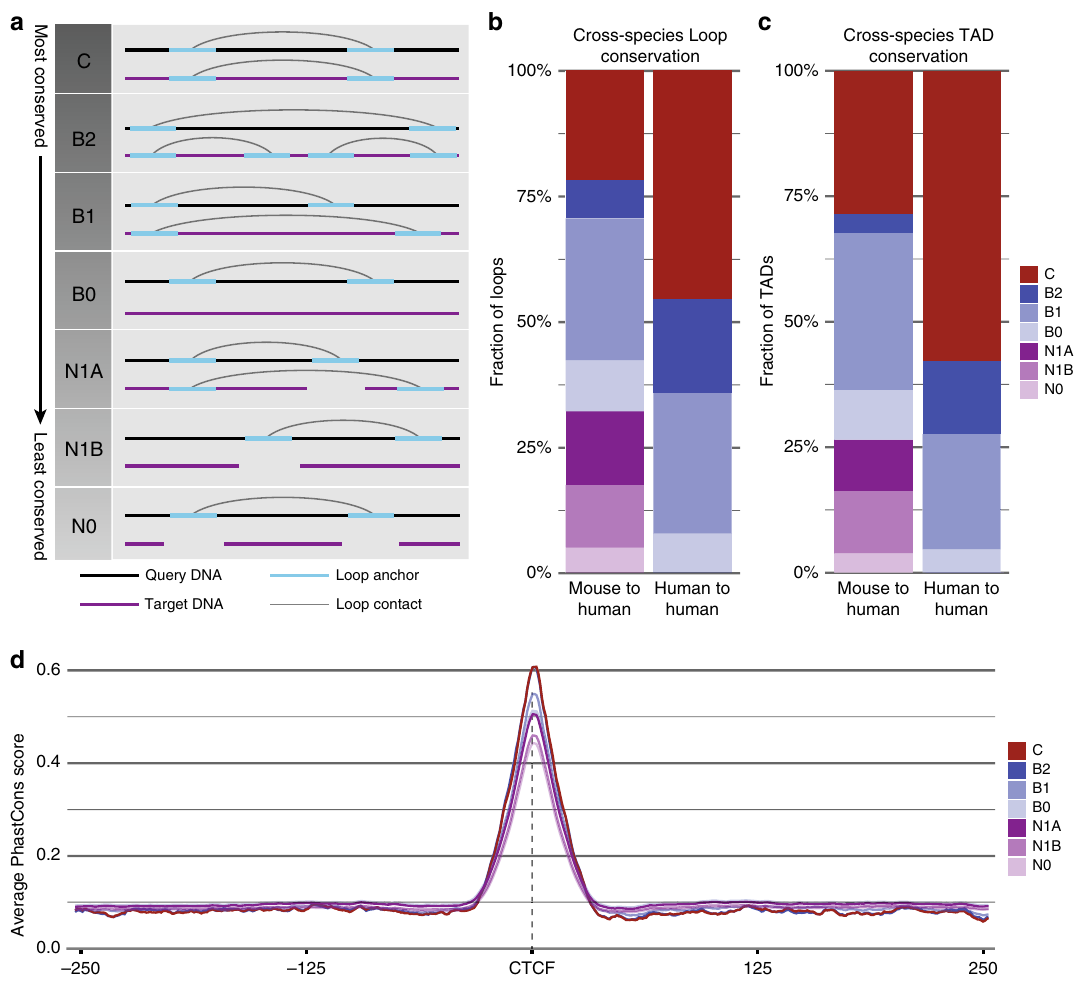
Fig. 5 Conservation classes describe loop co-occurrence patterns across cells and species, and are correlated with underlying phylogenetic conservation. a Conservation classes describe varying degrees of loop conservation between a query cell and a target cell based on sequence mappability and presence of a loop anchor at the syntenic locus. Diagrams illustrate the possible arrangements when comparing a query loop to a syntenic region in the target cell, with their corresponding conservation class labels. b , c Conservation class assignments from all pairwise comparisons between different cell types were aggregated into human – human and mouse – human comparisons. b Contributions of each conservation class to all chromatin loops. c Contributions of each conservation class to the subset of loops corresponding to known TADs. d Average phastCons conservation scores in 500 bp windows centered at the CTCF ChIP-seq peak summit within human GM12878 loop anchors plotted for each conservation class, with CH12 used as the target